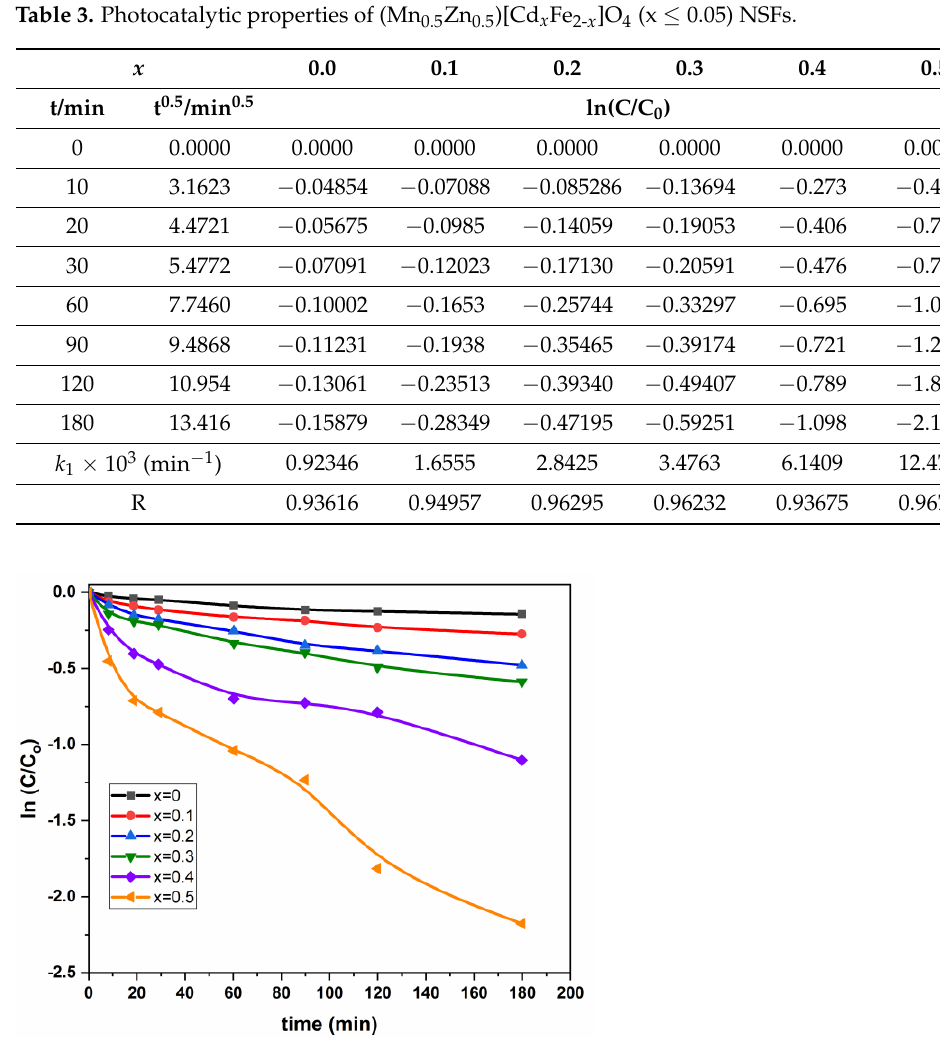
Figure 7. Variation of ln C/C0 vs time for (Mn 0.5 Zn 0.5 )[Cd x Fe 2- x ]O 4 (x = 0.1, 0.3 and 0.5) NSFs .